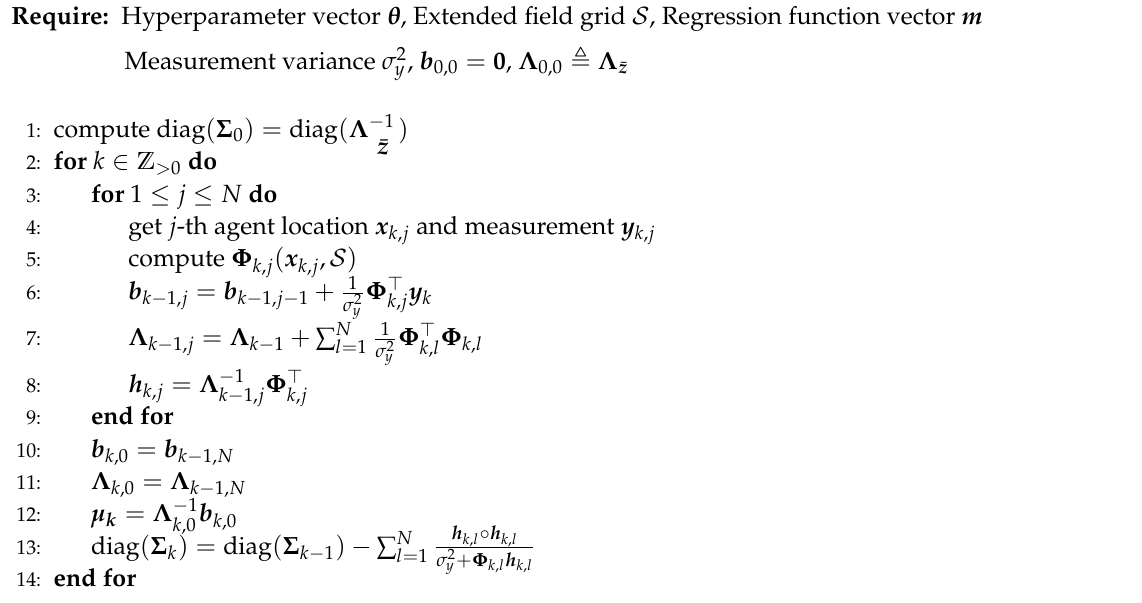
Algorithm 1 Sequential GMRF Regression